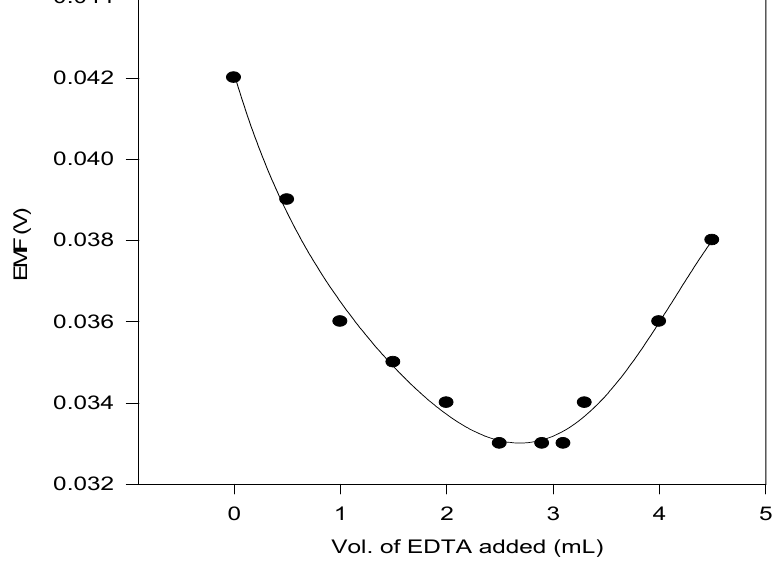
Figure 5. Titration curve of Sm (III) ions with EDTA solution using Sm (III) selective electrode based on